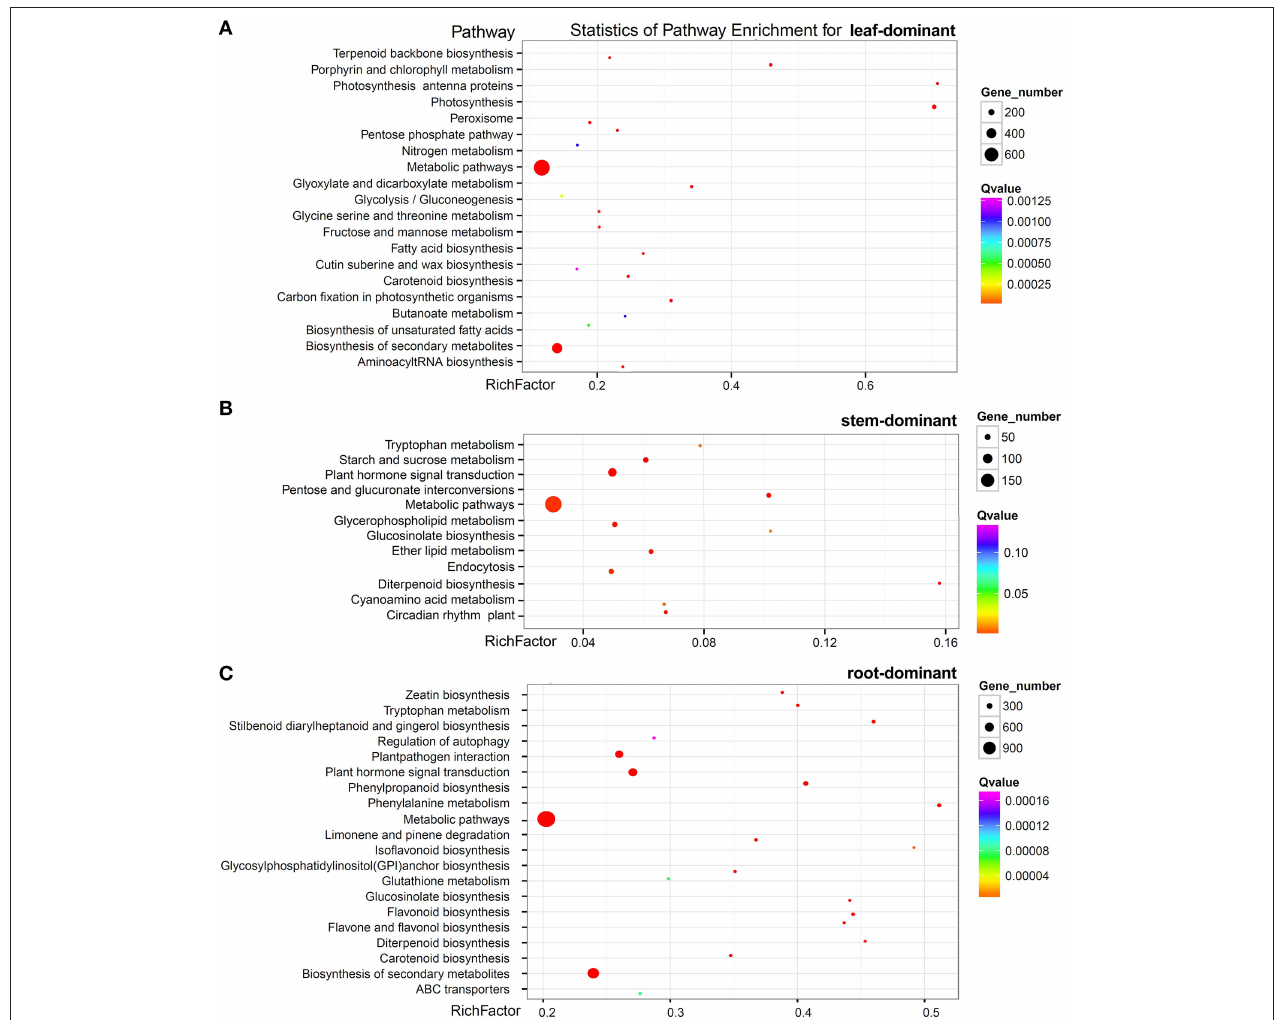
FIGURE 6 | Pathway enrichment of genes predominantly expressed in the leaf (A) the stem (B) and the root